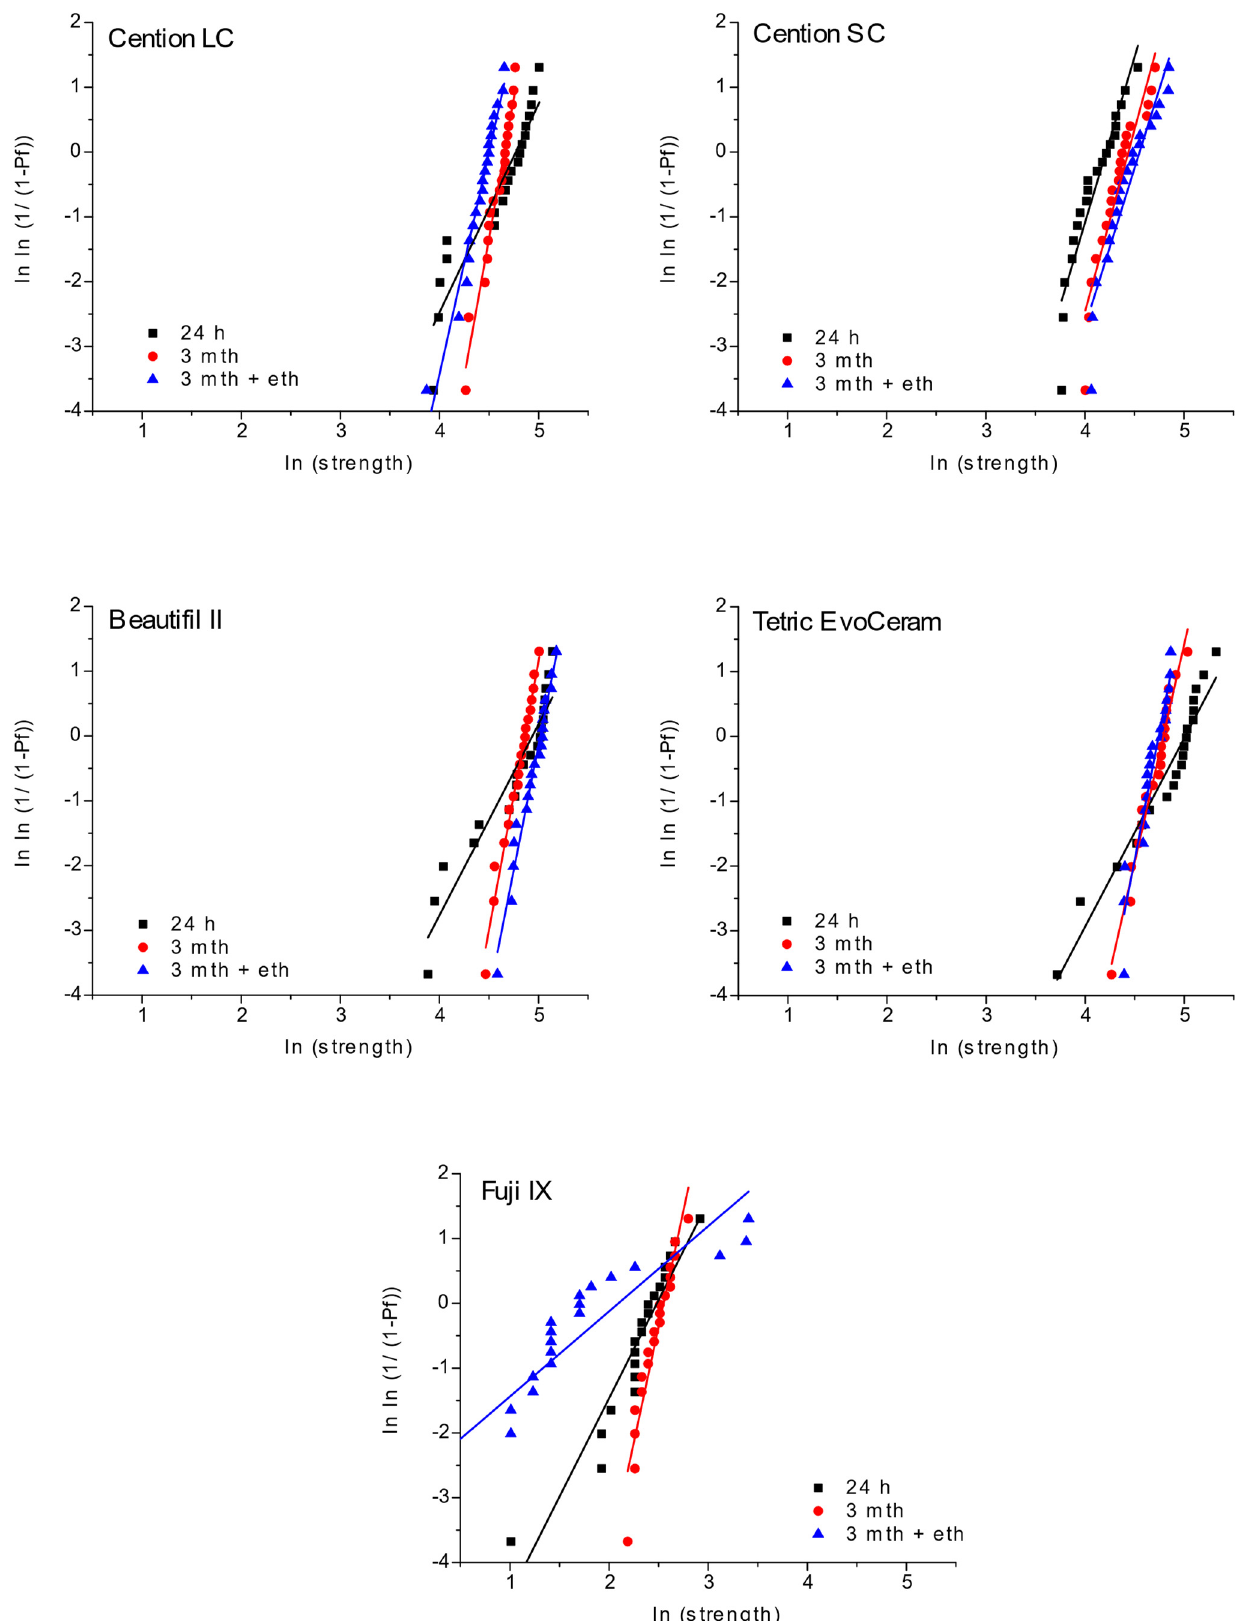
Figure 4. Weibull plots for tested materials and time points of measurement.